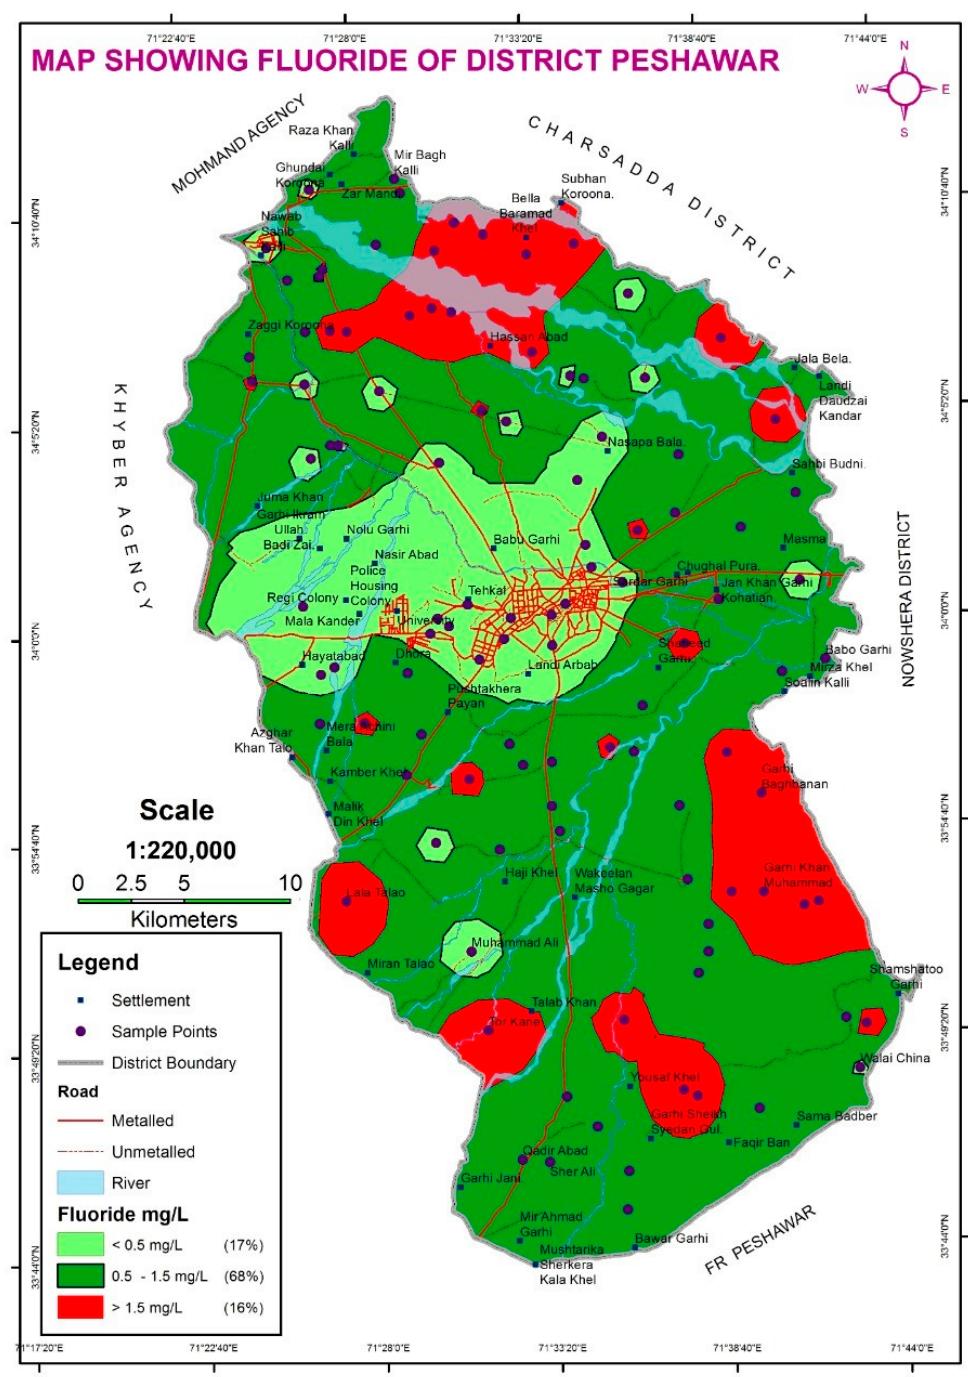
Figure 5. Fluoride concentration levels spatial distribution map of Peshawar.